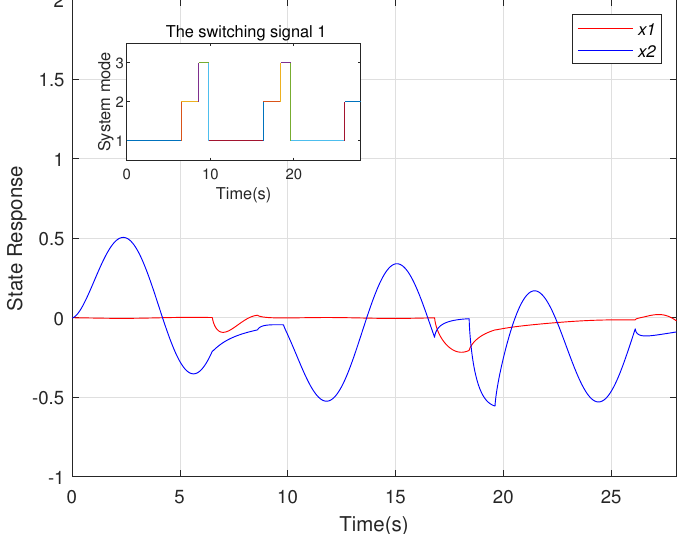
Figure 1. The state response of the system under the signal 1.